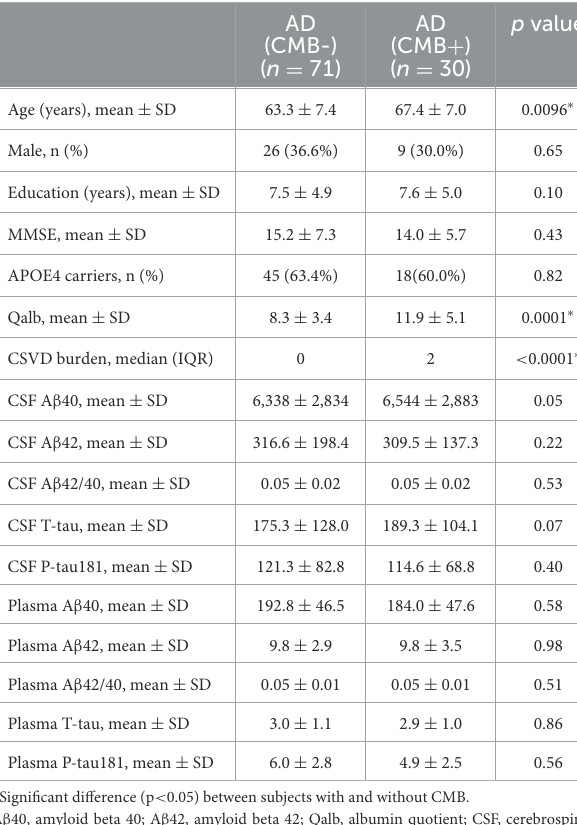
TABLE 2 Demographic characteristics and fluid biomarkers of AD subjects with or without